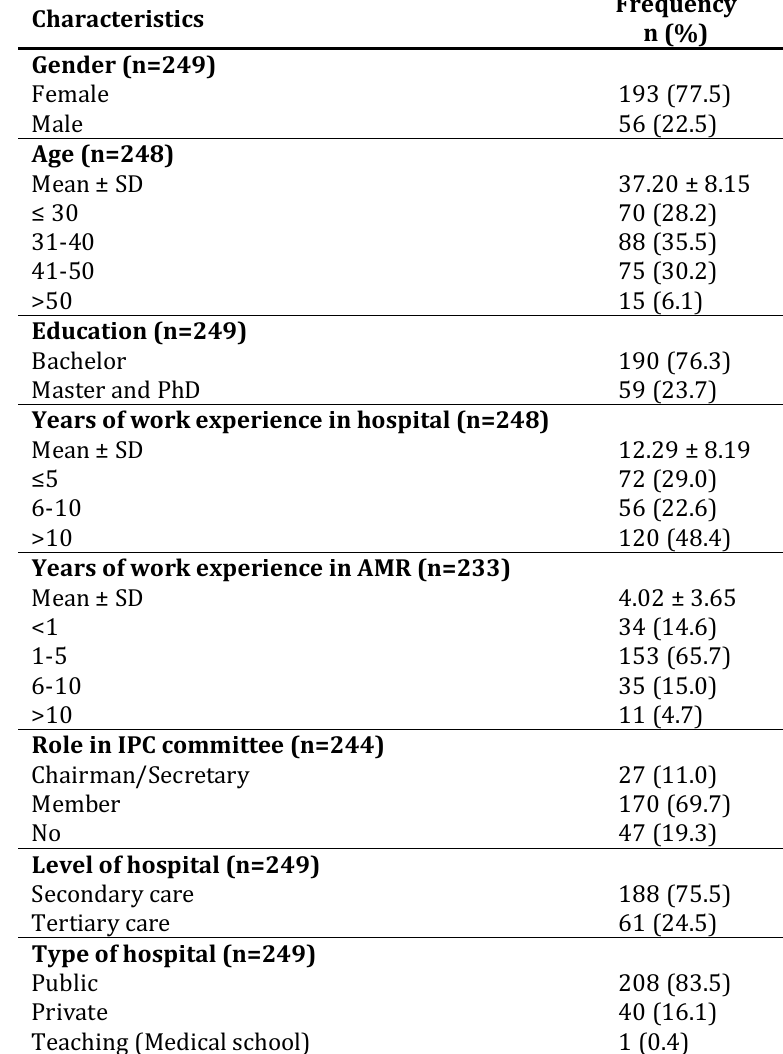
Table 1: Demographic characteristics of respondents